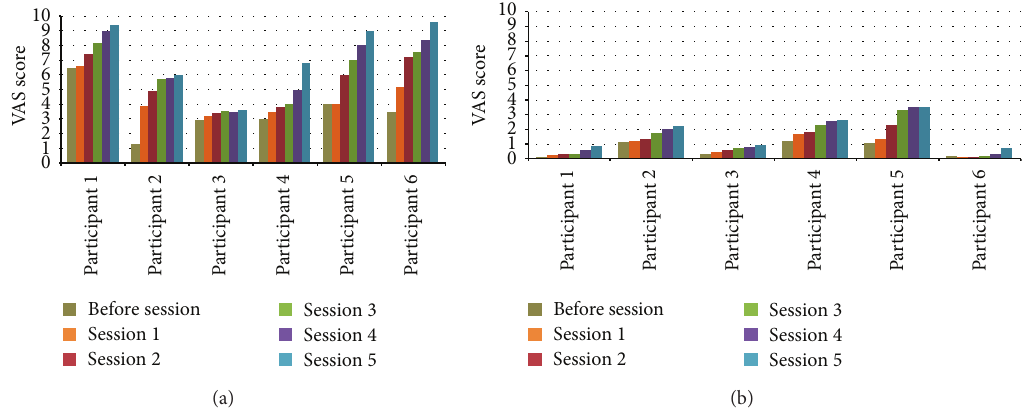
Figure 6: Participant’s subjective perception on muscle fatigue over the 5 training bouts (3 󸀠 each): MS participants (a) and healthy participants